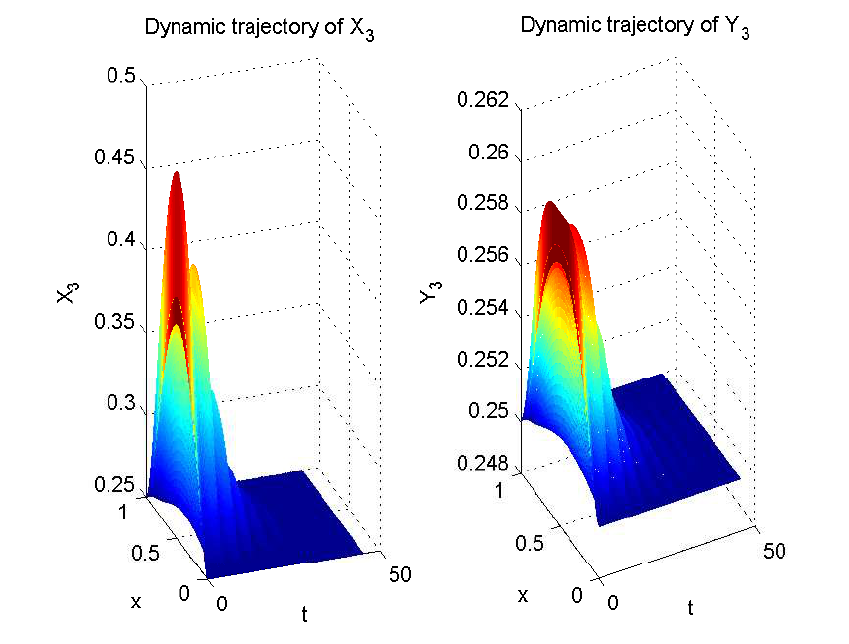
Figure 3. Computer simulation of X 3 in (3) and Y 3 in